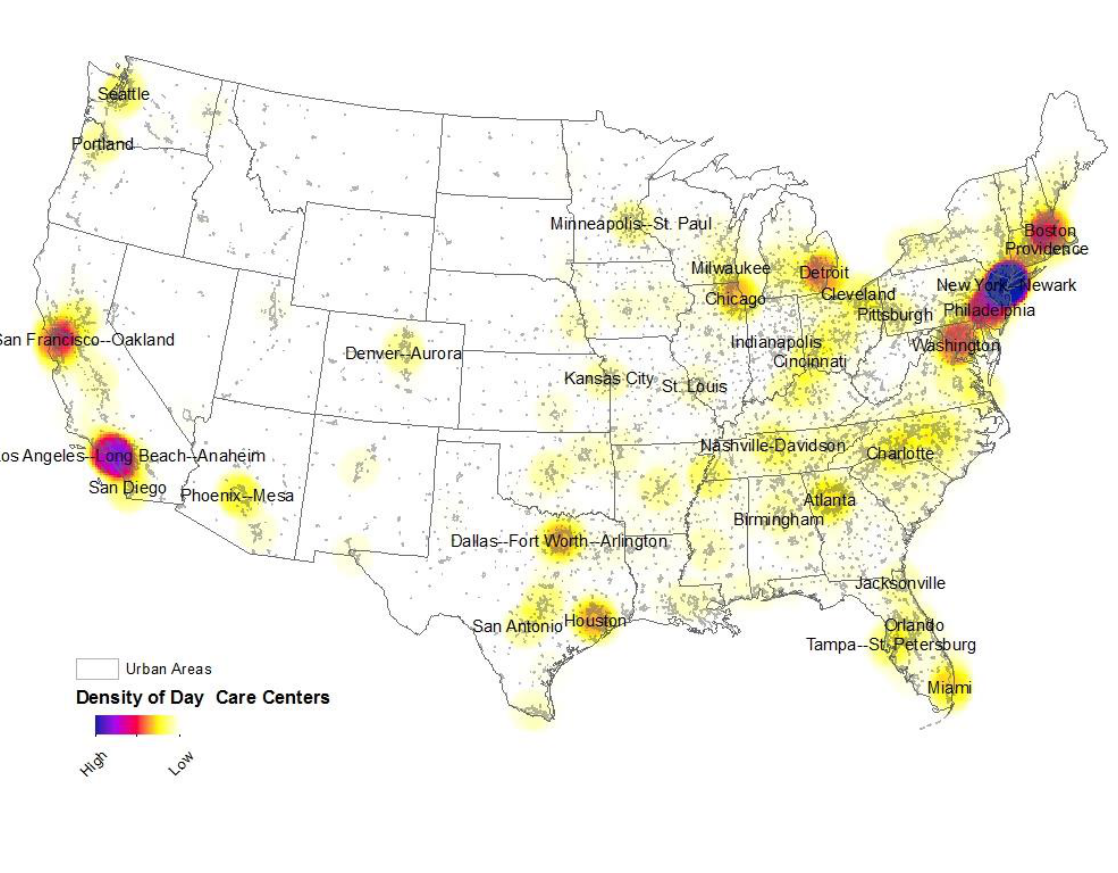
Figure 3. Distribution of day care center hotspots around urban areas as defined by the U.S. Census